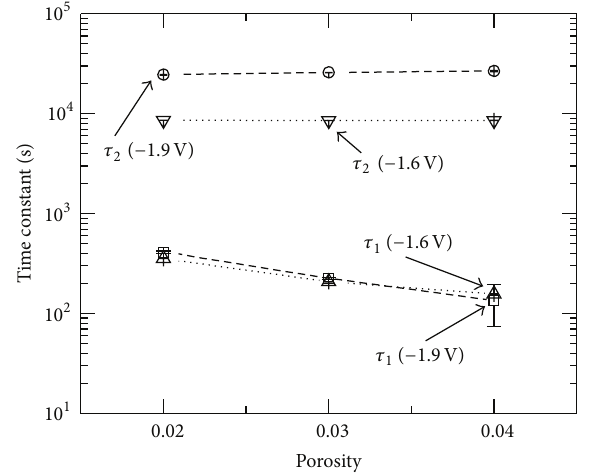
Figure 11: Time constants 𝜏 1 and 𝜏 2 as functions of porosity with applied potential as a parameter. The bulk conditions were 0.01M NaCl, pH 9, and 10 −15 M Al 3+ and the coating was 0.1 mm thick.